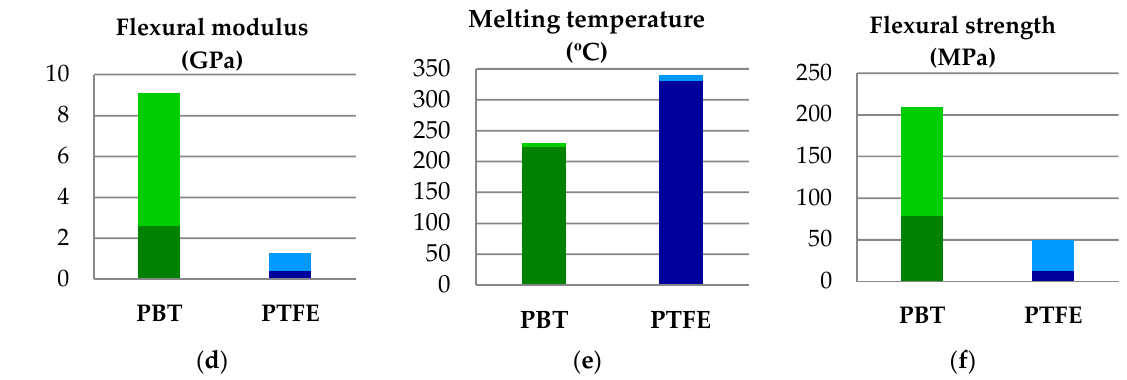
Figure 1. A comparison between characteristics for PBT and PTFE: ( a ) density; ( b ) elongation at break; ( c ) ultimate tensile strength; ( d ) flexural modulus; ( e ) melting temperature; ( f ) flexural strength. Mechanical characteristics are given for ambient temperature [24]. The dark color in each column represents the minimum value and the light color in each column is for the maximum value of the material characteristic.